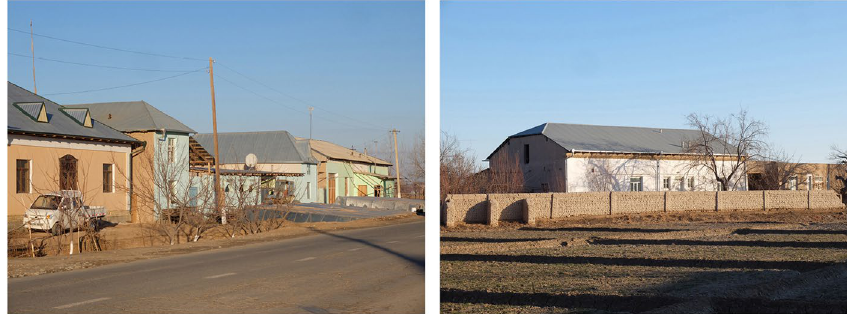
Fig. 2 Contemporary earthen houses in Uzbekistan (Source: the authors/CRAterre)